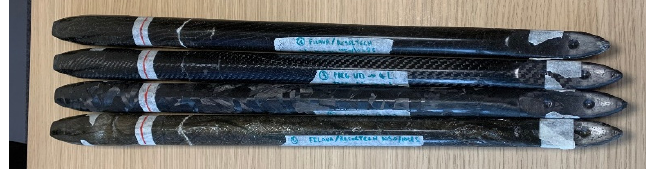
Figure 5. Image showing the fibre orientation and warp yarn in quasi quadriaxial fabric .